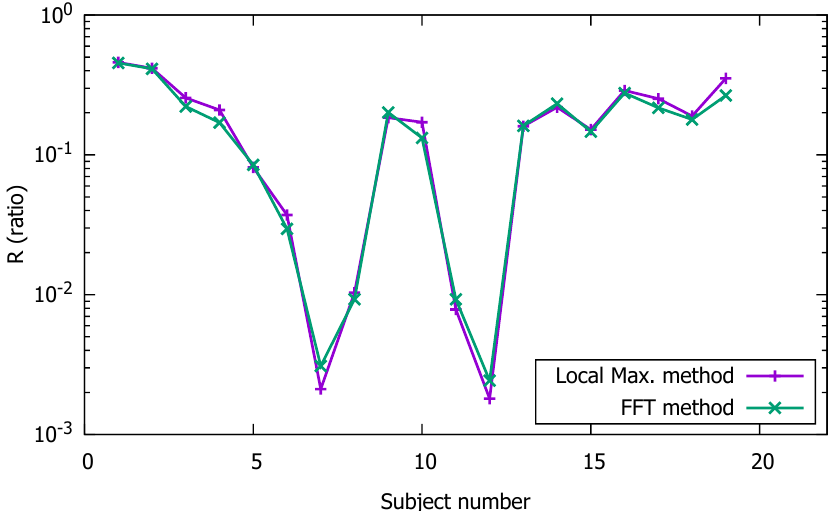
Figure 9. Ratio-of-ratios for a group of 19 healthy individuals calculated using the FFT method and the local maximum